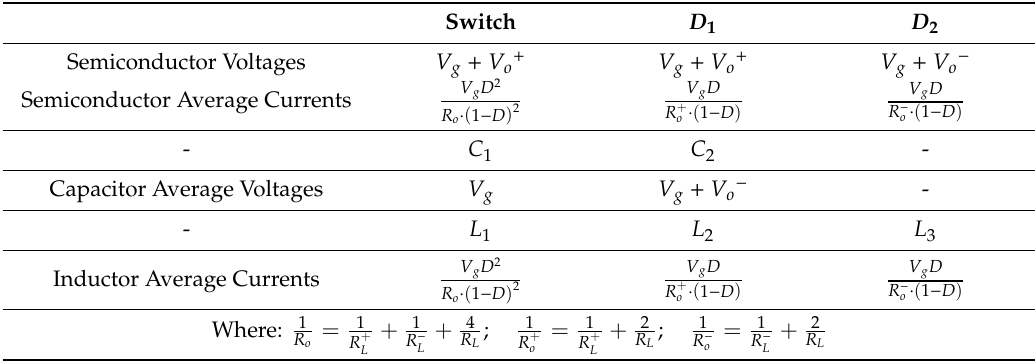
Table 1. Performance of the combination of SEPIC (single-ended primary-inductor converter) and ´Cuk